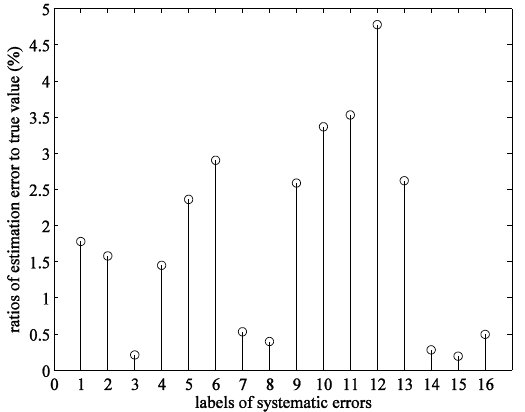
Figure 7. Ratios of estimation error to true value for systematic errors when λ = λ U .